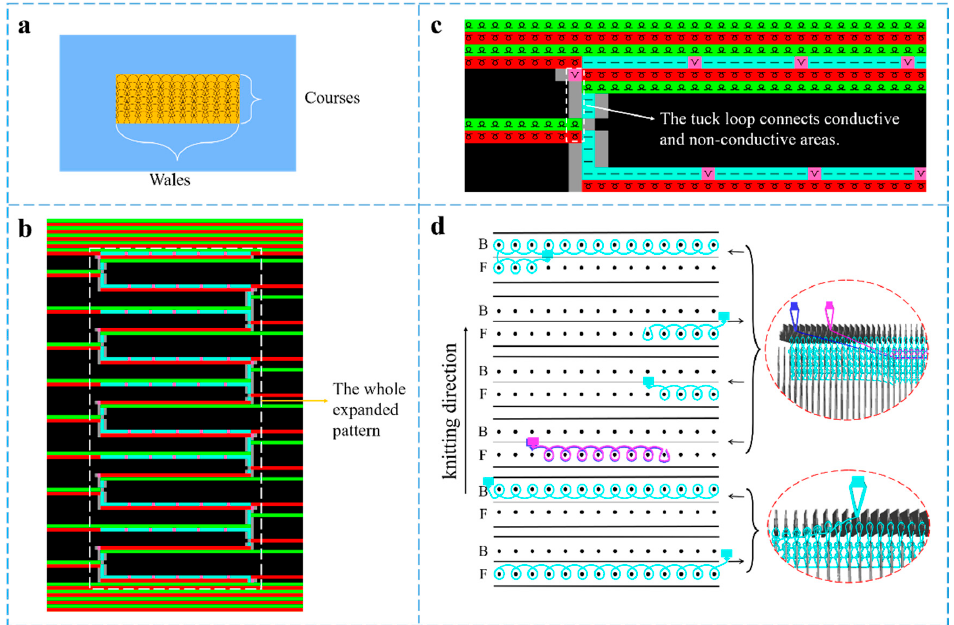
Figure 1. Pattern design and knitting process of the knitted strain sensor ( a ) compression pattern design ( b ) expanded pattern in the design system and ( c ) single pattern cycle ( d ) the knitting process and simulation of a single pattern.